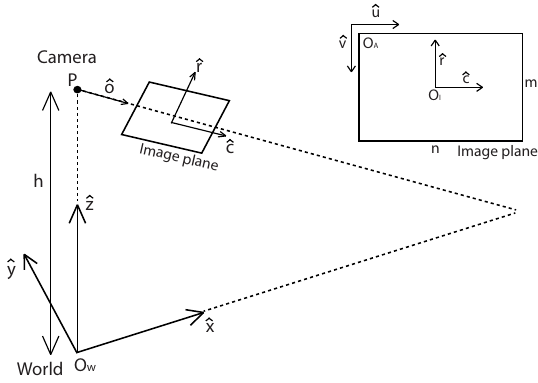
Figure 8. Coordinate the relationship between the camera, image and world. The unit of ( ˆ u , ˆ v ) is the pixel measurement, and that of (ˆ r , ˆ c ) and ( ˆ X , ˆ Y , ˆ Z ) is the meter measurement. Reprinted, with permission, from Jeong et al. URAI 2016; c (cid:13) 2016